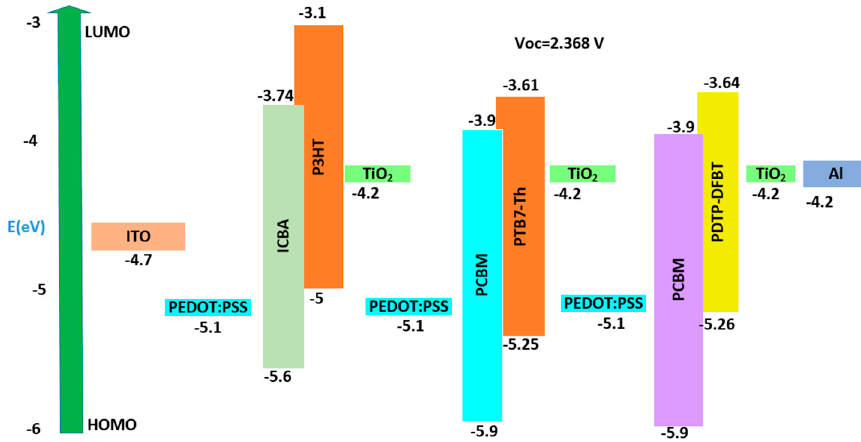
Figure 2. HOMO and LUMO band diagram for type 1 multi-junction PSC.